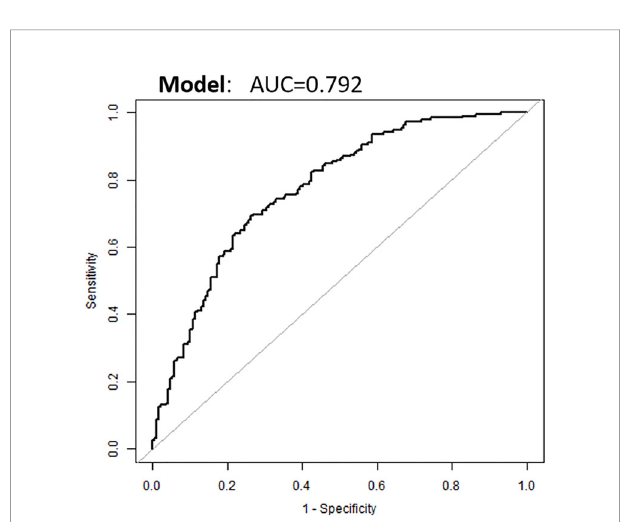
FIGURE 5 | Receiver operating characteristic curve of the